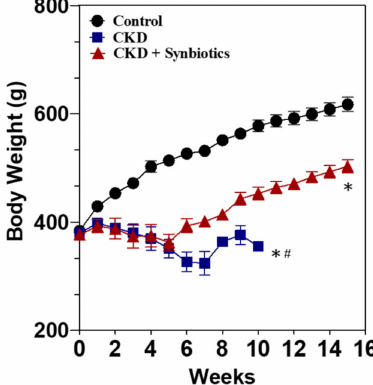
Figure 6. The body weight changes in animal model 2. The bodyweight of the controls ( • ), CKD rats ( (cid:4) ), and synbiotics-treated CKD rats ( (cid:78) ). Adenine treatment causes animal death in the 10th week. A significant difference between the controls vs. CKD group vs. synbiotics-treated CKD group was analyzed using ANOVA. *, p < 0.05. A significant difference between the CKD group vs. the synbiotics-treated CKD group was analyzed using ANOVA. #, p < 0.05. n = 6 for each group. Abbreviation: CKD, chronic kidney disease. Table 4. The blood test of animal model 2. Adenine treatment causes animal death in the 10th week. All data were presented as means ± SEM. A significant difference between the controls vs. CKD group vs. synbiotics-treated CKD group was analyzed using ANOVA. *, p < 0.05. n = 6 for each group. A significant difference between the CKD group vs. the synbiotics-treated CKD group was analyzed using ANOVA. #, p < 0.05. Abbreviation: CKD, chronic kidney